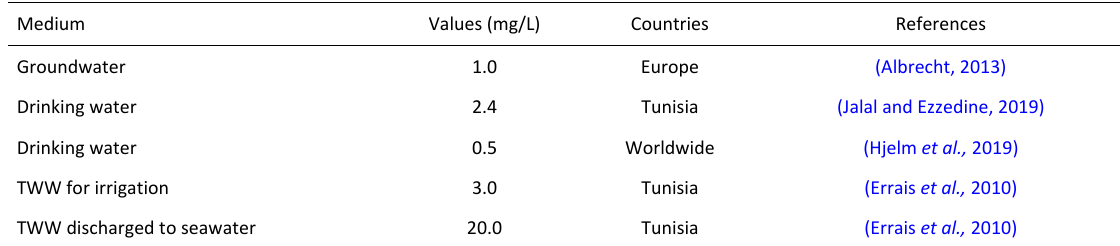
Table 1: Boron Thresholds values and recommendations for different water uses and countries.